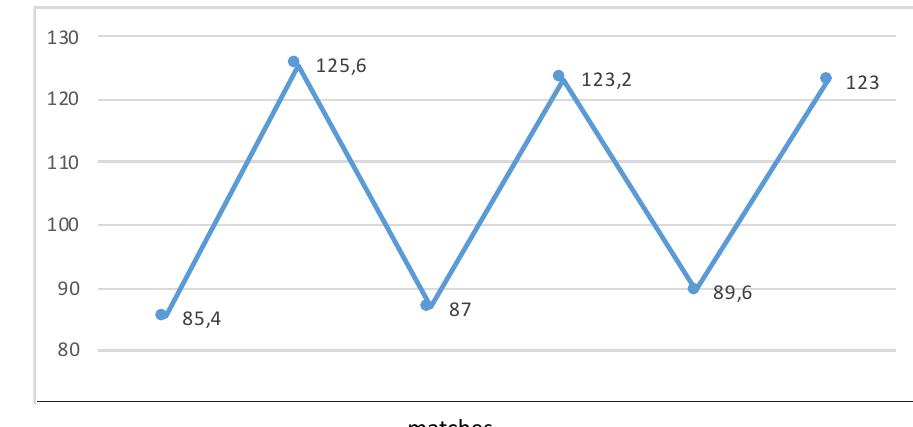
Figure 1. Lactate responses of female university students before and after beach handball matches